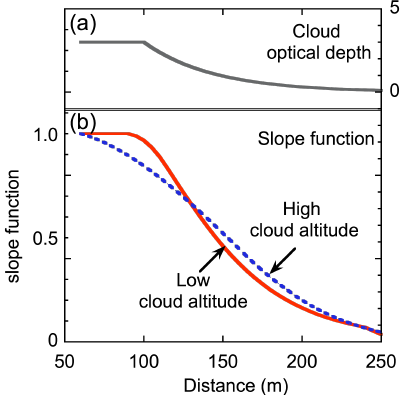
Fig. 9. An ideal case for investigating impact of cloud-base alti- Figure 9. An ideal case for investigating impact of cloud-base altitude on the slope function of 3 tude on the slope function of the transition zone. (a) Cloud op- the transition zone. (a) Cloud optical depth as a function of distance. Distance less than 100 m is 4 tical depth as a function of distance. Distance less than 100m is in cloudy areas, while distance greater than 250 m is clear-sky areas. (b) Slope functions for the 5 in cloudy areas, while distance greater than 250m is clear-sky ar- low and high clouds, as plottted by red-solid line and blue-dashed line, respectively. Slope 6 eas. (b) Slope functions for the low and high clouds, as plottted by functions are derived from simulated radiances at 400–870 nm wavelengths. Results from 2110– 7 red-solid line and blue-dashed line, respectively. Slope functions 2220 nm wavelengths are similar (not shown). 8 are derived from simulated radiances at 400–870nm wavelengths. Results from 2110–2220nm wavelengths are similar (not